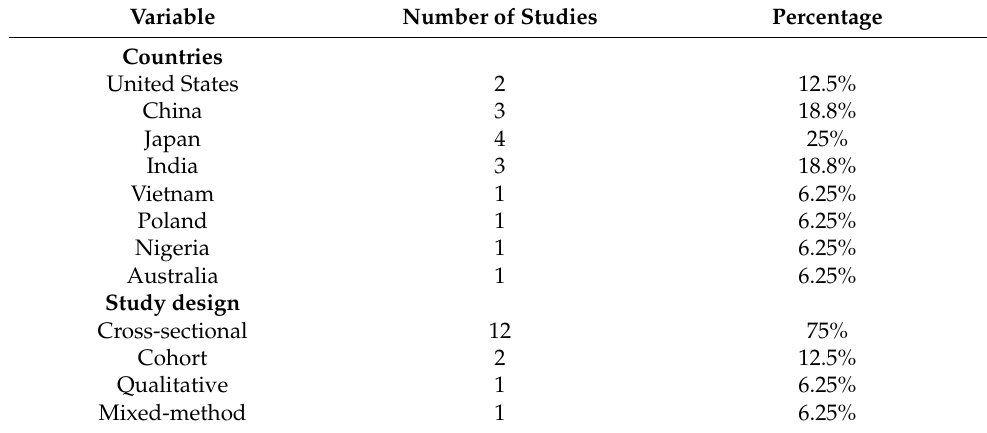
Table 3. Distribution of reviewed studies by countries and research